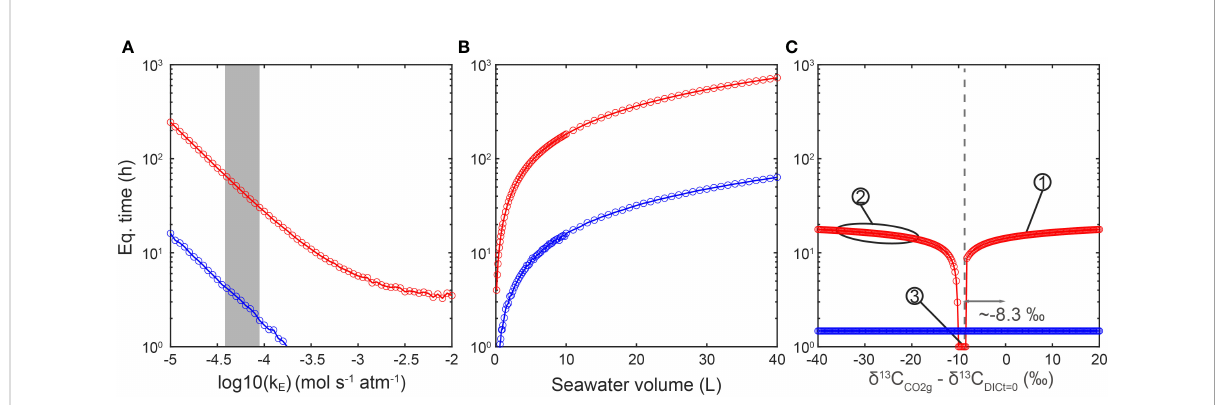
FIGURE 4 Sensitivity tests of different parameters effects on equilibration time. (A) Both isotopic (red) and chemical (blue) equilibration times decrease with the increase of gas exchange rate constant. The grey shaded area represents the estimated gas exchange rate constants in this work, ranging from 10 -4.4 to 10 -4.1 mol s -1 atm -1 . (B) Both isotopic (red) and ordinary (blue) equilibration times increase with the increase of seawater volume. (C) The DIC carbon isotope reaches equilibrium faster when the carbon isotope ratio difference between DIC and CO 2 (g) is around 8.3 ‰ (same as the ϵ 1 in Figure 3), which is the equilibrium fractionation between DIC and CO 2 (g) at 291.15K. The carbon isotope difference does in fl uence equilibration time especially when the difference is between -20 ‰ and -8.3 ‰ . Numbering illustrates isotopic ratio differences in representative experiments here and in published works: No. 1 marks a D t=0 = 1.7 ‰ in k E measurement experiments in this study. No. 2 marks D t=0 ranging from about -37 to -17 ‰ in several other works (e.g., Liu et al., 2018; Phelps et al., 2021). No. 3 marks a D t=0 around -9 ‰ (Tchernov et al.,